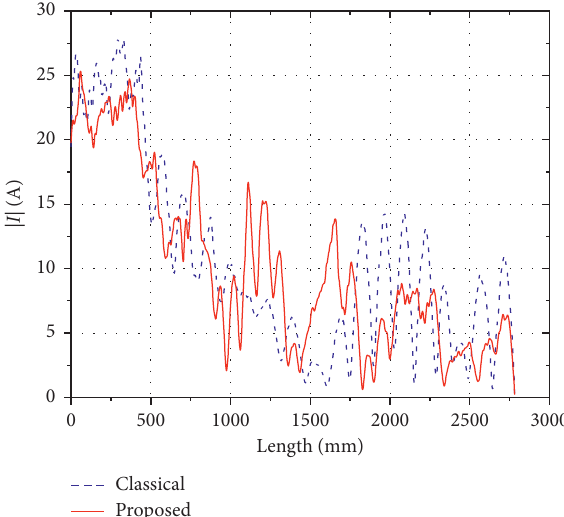
Figure 5: Current distribution along the antenna arms at